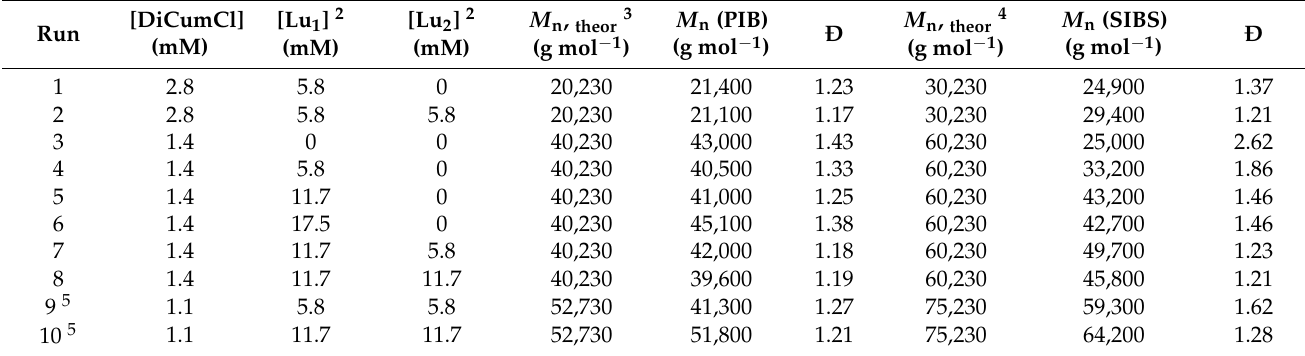
Table 1. Synthesis of triblock copolymers of isobutylene with styrene (SIBS) using DiCumCl/TiCl 4 /Lu initiating system 1.